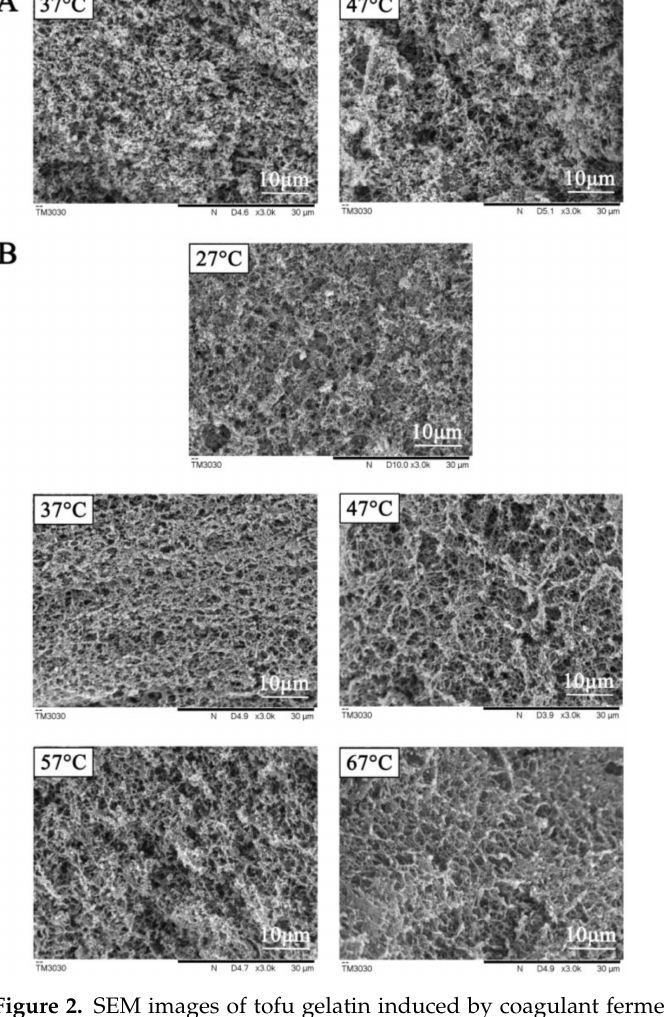
Figure 2. SEM images of tofu gelatin induced by coagulant fermented using L. paracasei ( A ) and L. plantarum ( B ) at different